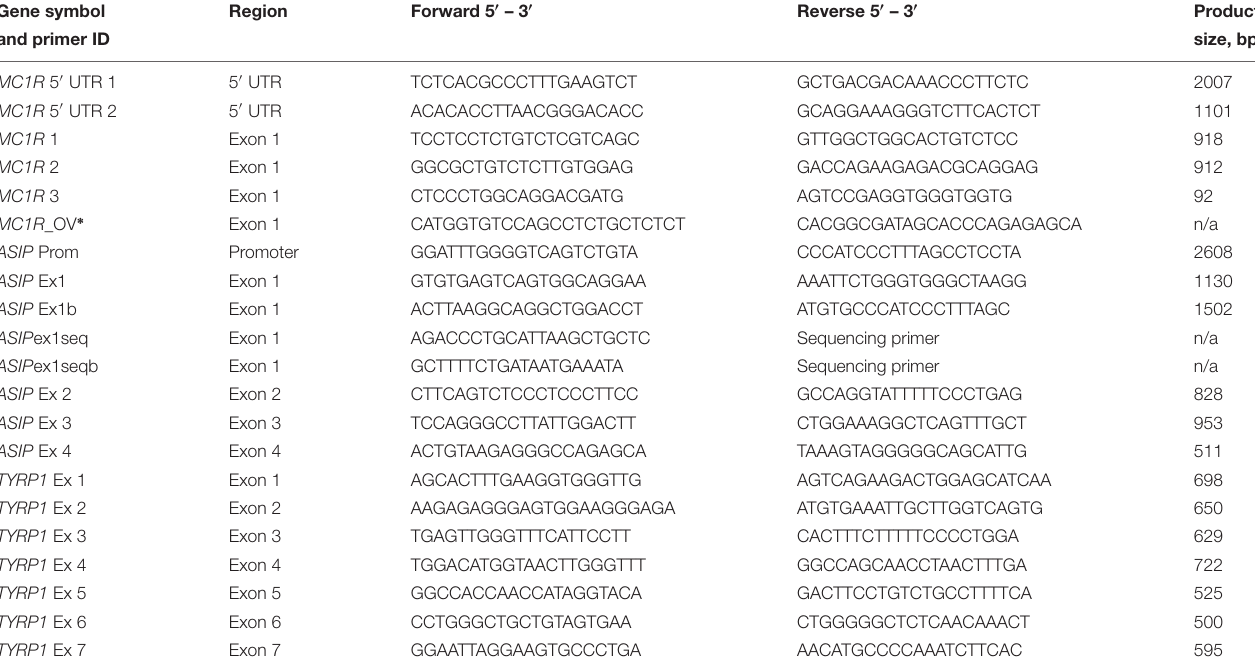
TABLE 1 | Primers used for PCR and sequencing of MC1R , ASIP, and TYRP1. Gene symbol Region Forward 5 (cid:48) – 3 (cid:48) Reverse 5 (cid:48) – 3 (cid:48)